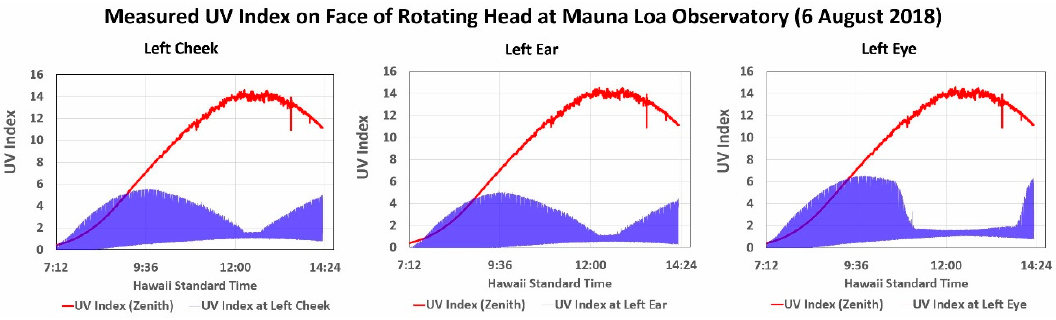
Figure 5. Variation in UVR measured across the face of the rotating mannequin head during a deployment at the Mauna Loa Observatory.